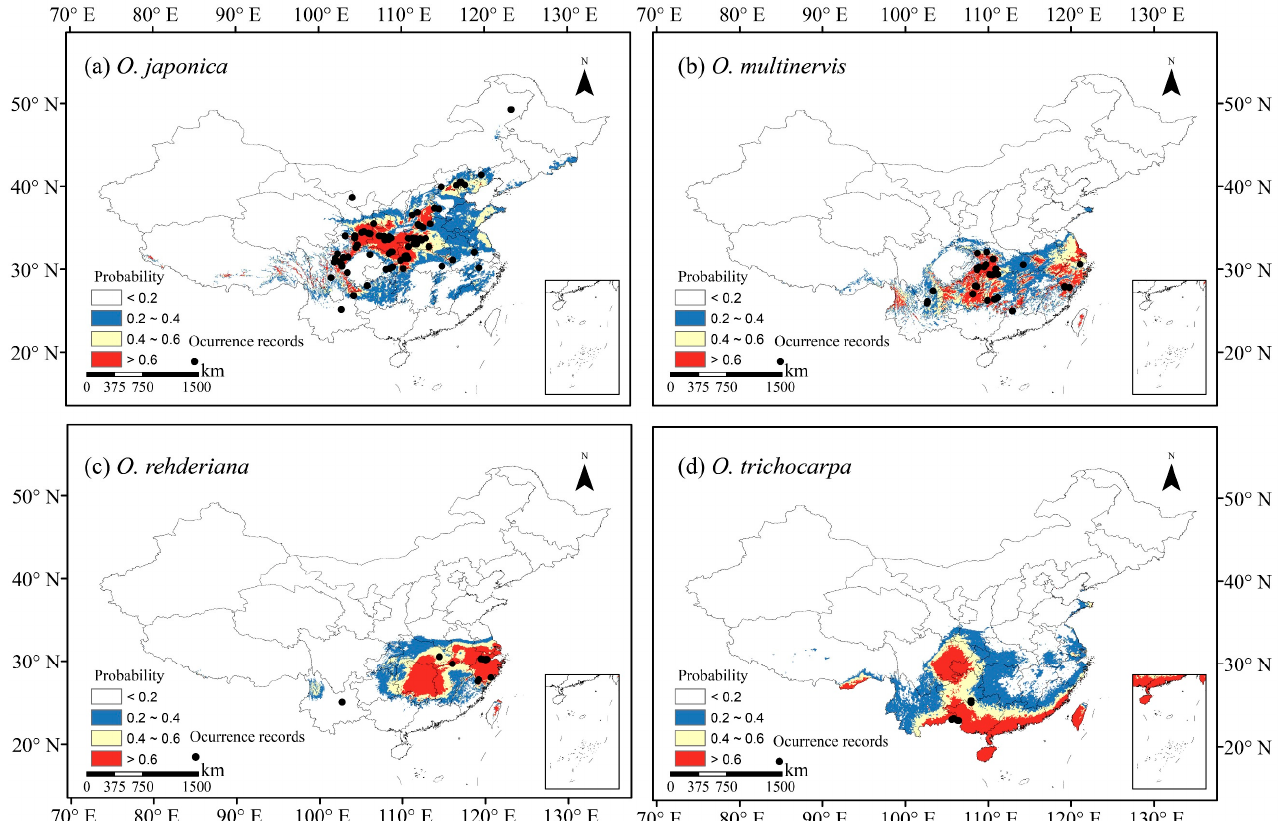
Figure 1. Occurrence records used in models and potential habitats in China of four species of Ostrya , i.e., O. japonica ( a ), O. multinervis ( b ), O. rehderiana ( c ), and O. trichocarpa ( d ), under present climate scenario. Note: Black dots represent the occurrence record locations of species in China. The values for species occurrence probability ranged between 0 and 1, i.e., least potential (<0.2), moderate potential (0.2–0.4), good potential (0.4–0.6), and high potential